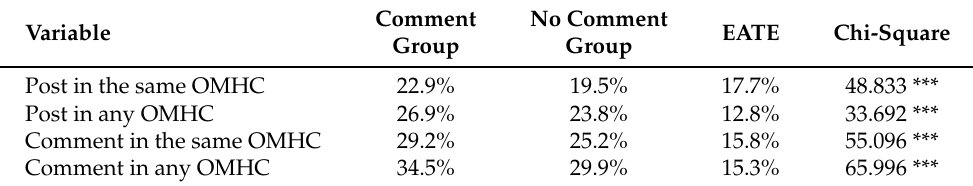
Table 1. Comparing the return probability of “comment group” and “no comment group”. EATE (estimated average treatment effect) = ( Y ( treatment ) − Y ( control )) / Y ( control ) , Y = outcome variable . *** p <